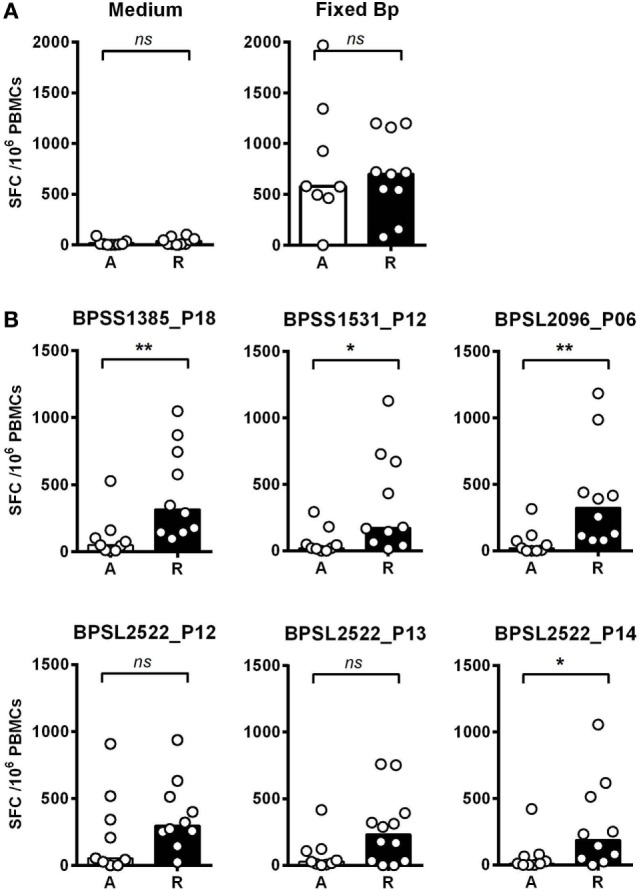
IFNγ responses to Burkholderia pseudomallei (Bp) and T-cell immunoprevalent peptides in patients with acute septicemic melioidosis compared with recovered individuals. IFNγ response to the top six immunoprevalent peptides of Bp measured by ELISpot analysis of peripheral mononuclear cell (PBMC) taken from patients with a diagnosis of acute melioidosis (A, n = 9) and melioidosis recovered individuals (R, n = 10). (A) shows the results for medium only control and paraformaldehyde (PFA) fixed Bp. (B) shows the results for six immunoprevalent peptides. Statistical significance was determined using Mann–Whitney U test; ns, not significant, * p < 0.05 and ** p < 0.01.